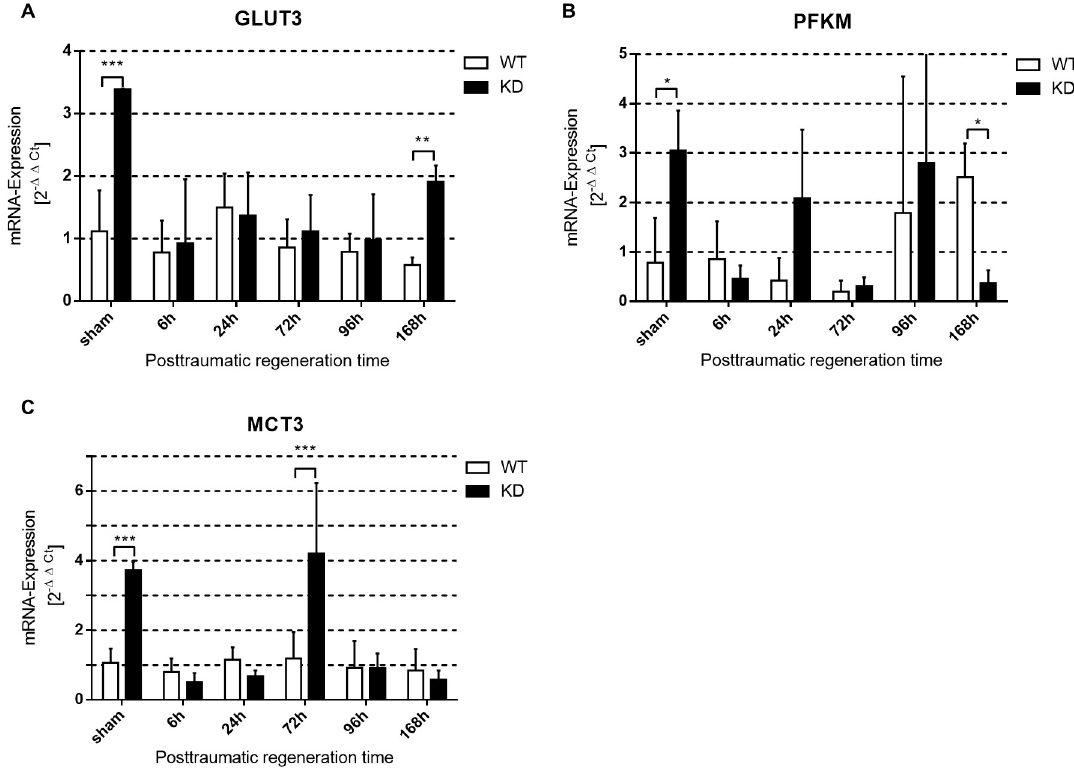
Fig 7. Genes of the glucose and lactate metabolism after trauma are enhanced in Phd2 -hypomorphic mice. qPCR analysis (whole muscle tissue) of selected factors of glucose and lactate metabolism in myotrauma of traumatic and sham treated wild type (WT) and Phd2-hypomorphic (KD) mice. (A) glucose transporter 3, Glut3 ; (B) phosphofructokinase muscle type, Pfkm ; (C) monocarboxylate transporter 3; Mct3 ). Glut3 is significantly induced in SHAM KD mice and 168h after trauma. There is a significant induction of Pfkm 168h after trauma in WT mice while Pfkm expression is reduced in KD mice. We observed a significantly induced Mct3 expression in sham treated KD mice and 72h after myotrauma (mean ± SD; n = 4–6; sham: n = 3). � P < 0.05, �� P < 0.01, ��� P < 0.001.